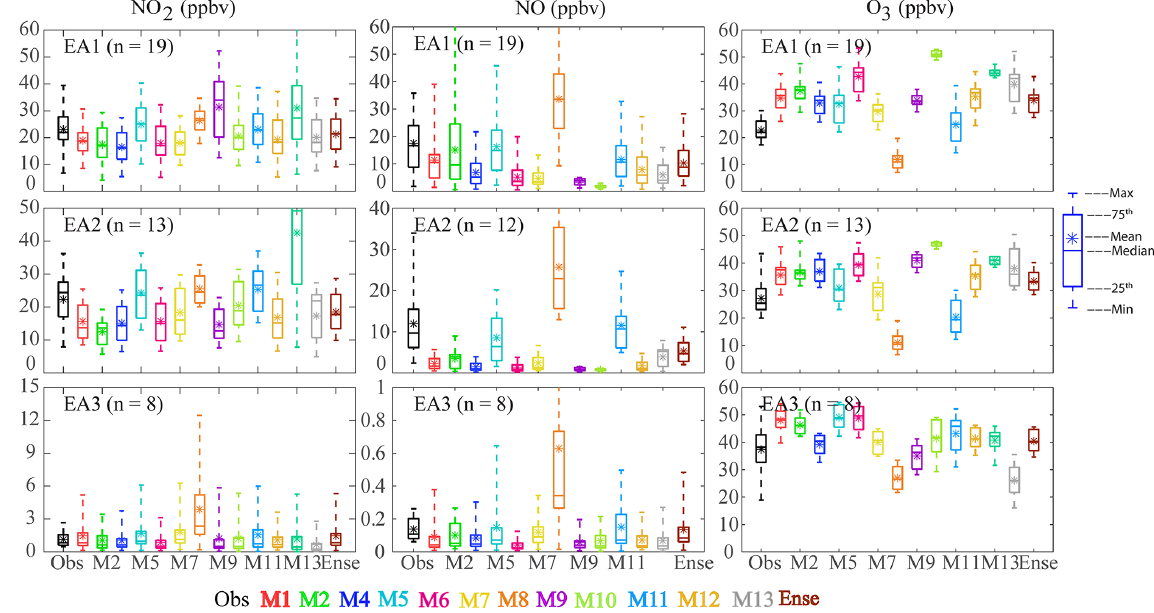
Figure 2. Box plots of the observed and simulated annual NO 2 (a, d, g) , NO (b, e, h) and O 3 (c, f, i) frequency distributions determined from 13 models and averaged for stations in EA1, EA2 and EA3 for 2010. n denotes the number of stations. The rectangle represents the interquartile range (25th to 75th percentiles). The asterisk identifies the mean, the continuous horizontal line within the rectangle identifies the median, and whiskers extend between the minimum and maximum